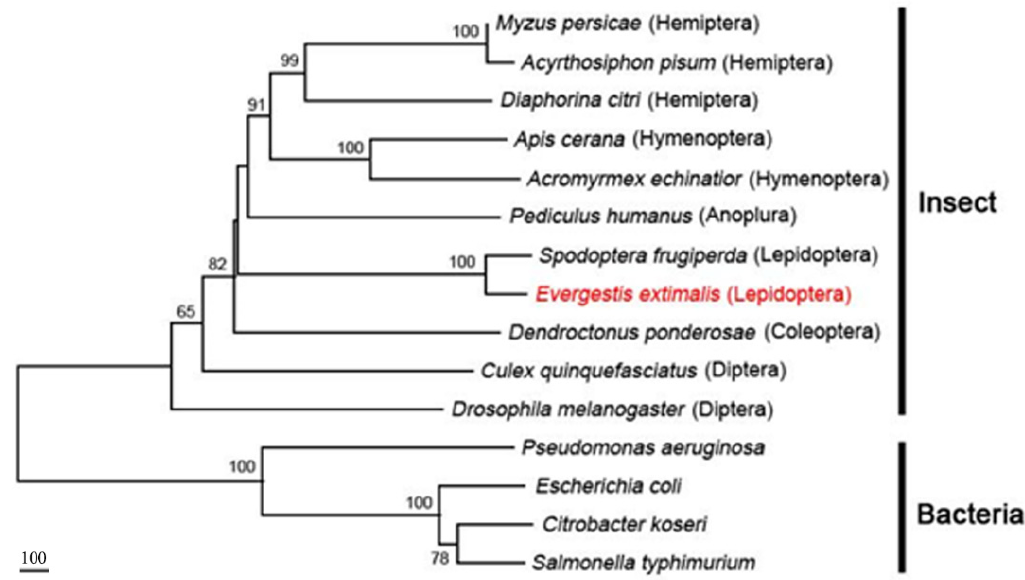
Figure 7. Phylogenetic analysis based on the amino acid sequence of trehalase. Bootstrap values for 1000 trials are indicated at each node.